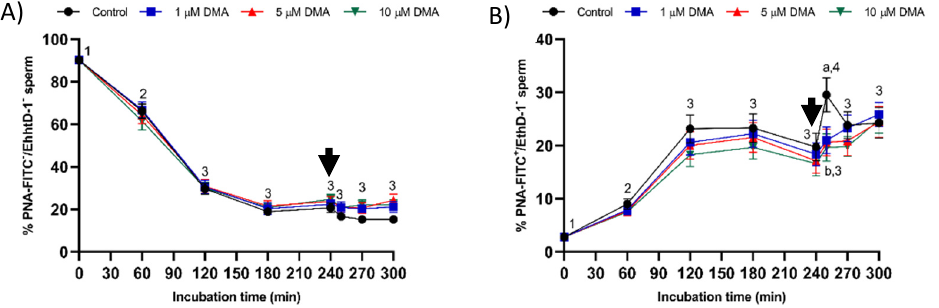
Figure 7. Percentages of viable sperm with an intact acrosome ( A ) and an altered acrosome ( B ) during in vitro capacitation in the control and samples blocked with 1, 5, and 10 µ M DMA. Different letter superscripts indicate significant differences between control and blocked samples within a single time point ( p < 0.05). Different numeral superscripts indicate significant differences between two consecutive time points within a treatment ( p < 0.05); since the pattern of variation of the percentage of viable sperm with an intact acrosome throughout the incubation time was similar between control and blocked samples, all treatments have the same numeral superscript assigned to each time point. The arrow indicates the addition of 10 µ g/mL of progesterone at 240 min of incubation. Results are expressed as the mean ± SEM ( n = 9).